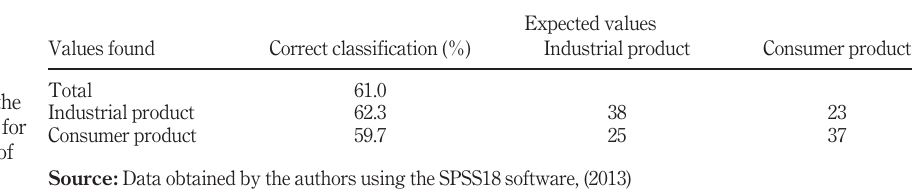
Table VII. Assertiveness of the classi fi cation tree for the variable type of